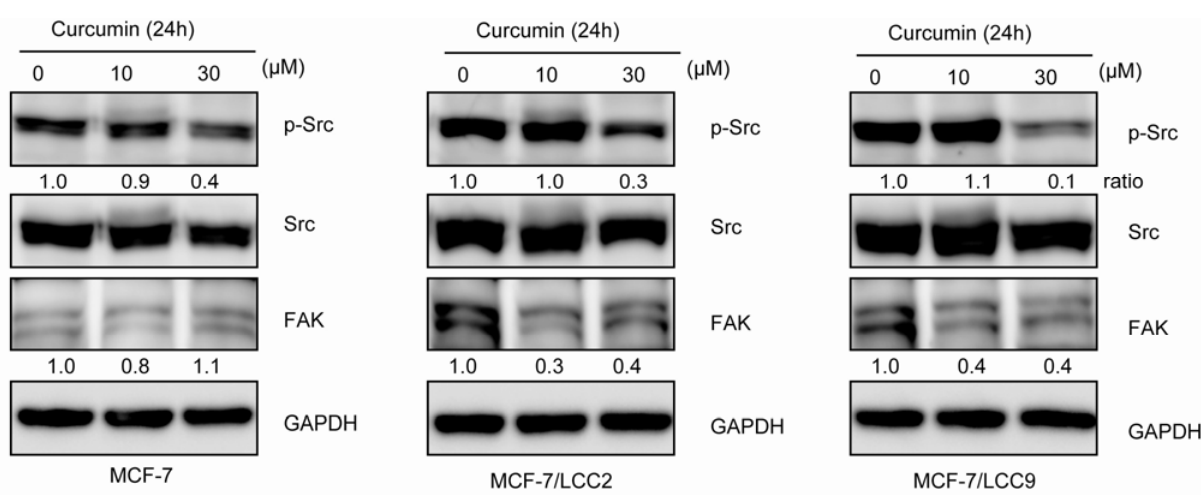
Figure 8. Curcumin inhibits Src/FAK in MCF-7/LCC2 and MCF-7/LCC9. Cells were treated with curcumin (10 and 30 μ M) for 24 h and the protein expression was detected by anti-FAK, anti-Src and anti-p-Src (Tyr418).